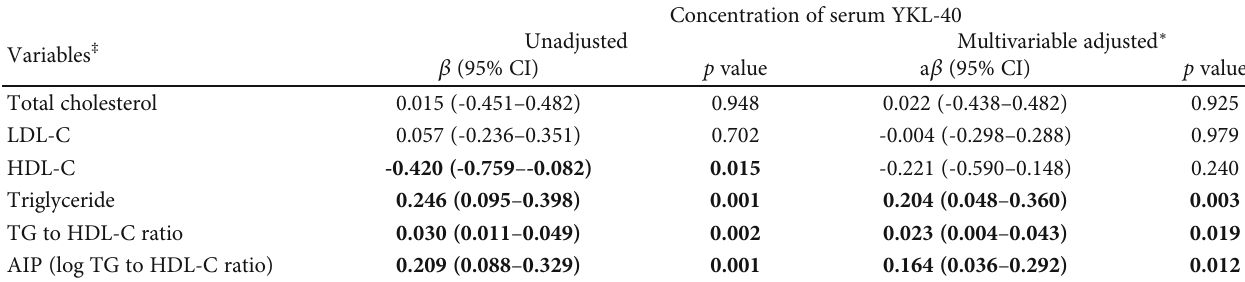
Table 4: Multivariate linear regression analysis for lipid parameters with serum